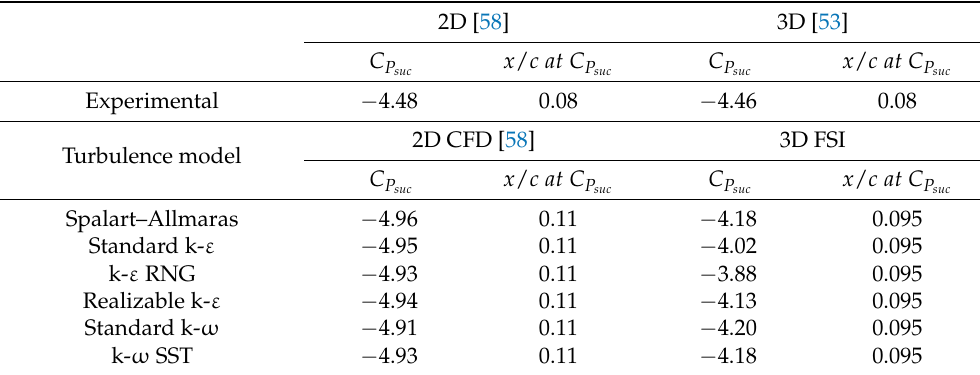
Table 4. Information on surface pressures for several turbulence models, h/c = 0.211. 2D